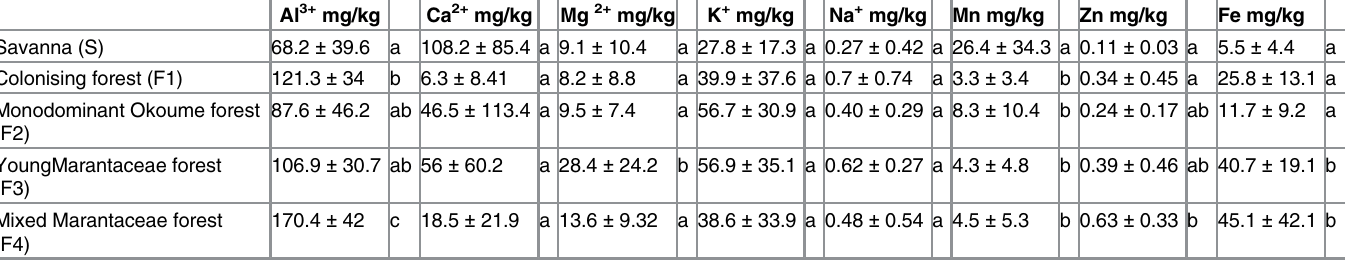
Table 2. Soil characteristics, 0-30cm depth, per forest type, for several weatherable